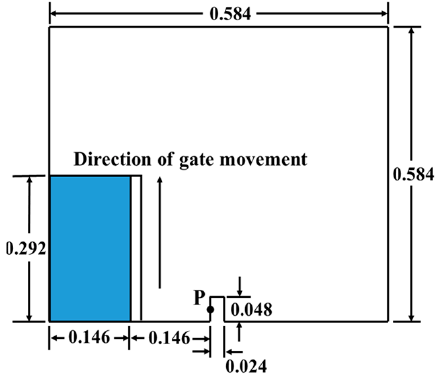
Figure 19. Calculation model with gate.